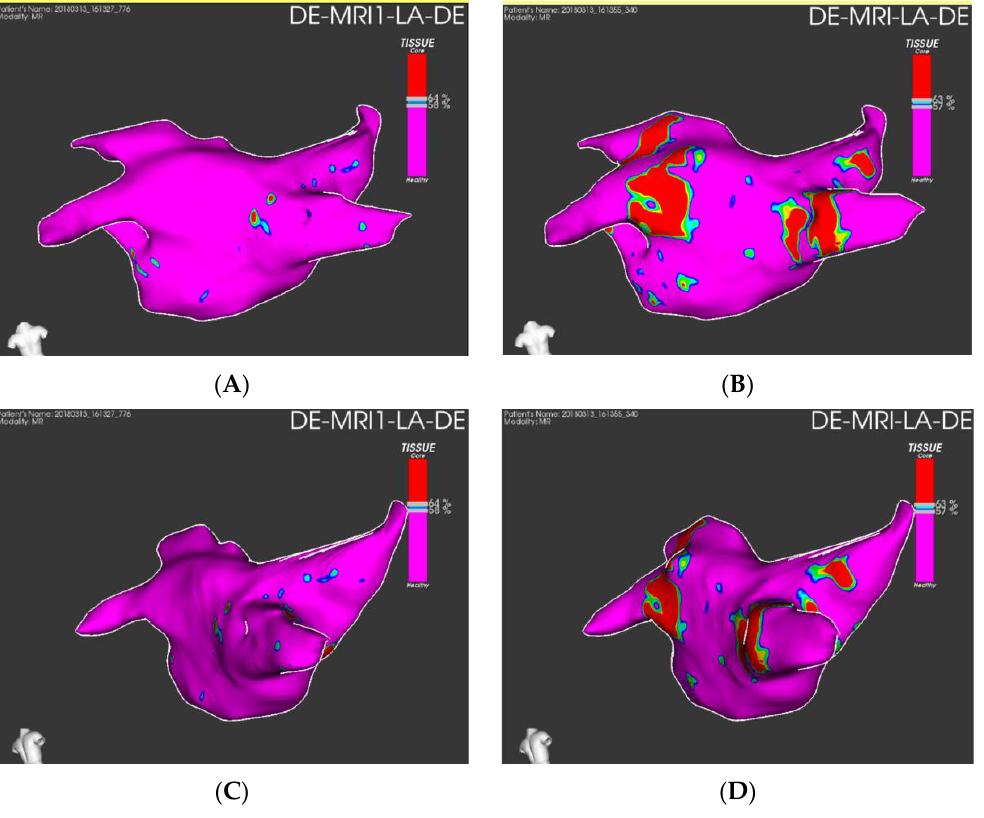
Figure 6. Quantification of preprocedural fibrosis (panel ( A , C ) and postprocedural fibrosis ( B , D ) on LGE-CMR images on ADAS 3D TM (ADAS3D Medical, Barcelona, Spain).